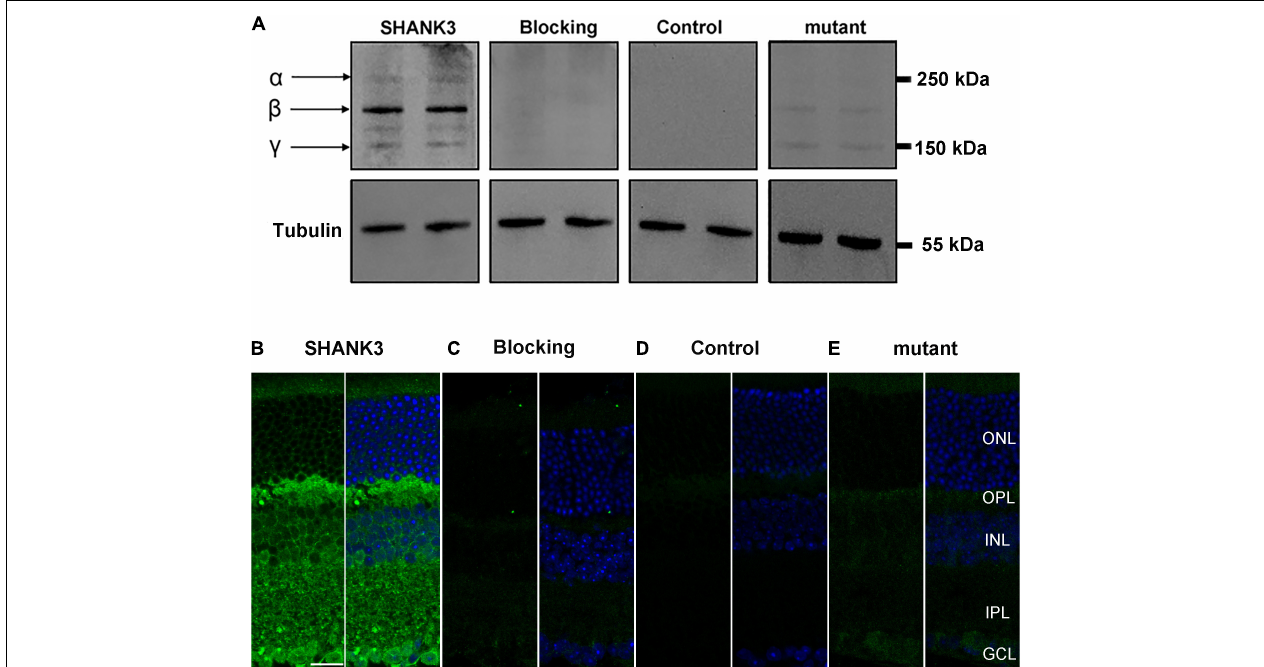
FIGURE 1 | Expression of SH3 and multiple ankyrin repeat domains protein 3 (SHANK3) in mice retina. (A) Western blot analysis confirmed that SHANK3 was specifically expressed in the retinal homogenates, with three SHANK3 isoforms at 150–250 kDa. No band was detected when the SHANK3 antibody was pre-absorbed with the immunizing antigen. The similar was find when the primary antibody was omitted. And when the shank3 was mutant, the bands of SHANK3 were reduced. (B) Confocal fluorescence microphotographs of a vertical section of the mouse retina, labeled by SHANK3. Fluorescence staining shows that the SHANK3 is widely distributed through the whole retina. (C) Micrographs of a retinal vertical section, showing that no signal was detectable when the primary antibody for SHANK3 was pre-absorbed with the immunizing antigen. (D) Micrographs of a retinal vertical section, showing that no signal was detectable when the primary antibody was omitted. (E) Micrographs of a retinal vertical section, showing that the shank3 was mutant, the signal of SHANK3 was reduced. ONL, outer nuclear layer; OPL, outer plexiform layer; INL, inner nuclear layer; IPL, inner plexiform layer; GCL, ganglion cell layer. Scale bar = 20 µ m.